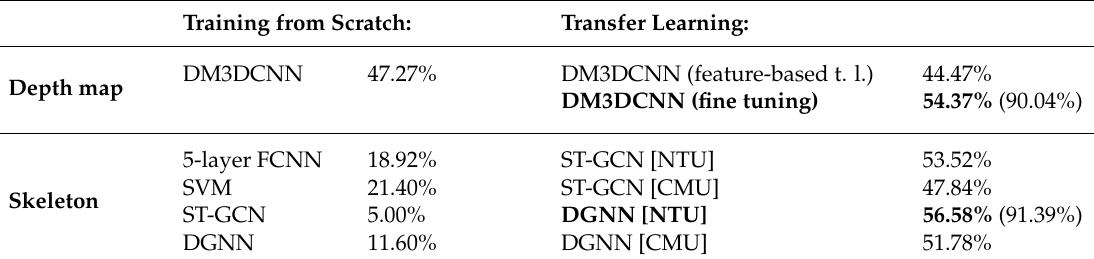
Table 1. Recognition accuracy (Top-1) on the Low-Moral Actions (LMA) dataset. (FCNN = fully connected neural network; for transfer learning on skeleton data the dataset used for pretraining is denoted in squared brackets.) For the two highlighted best methods we also denote the Top-5 accuracy in